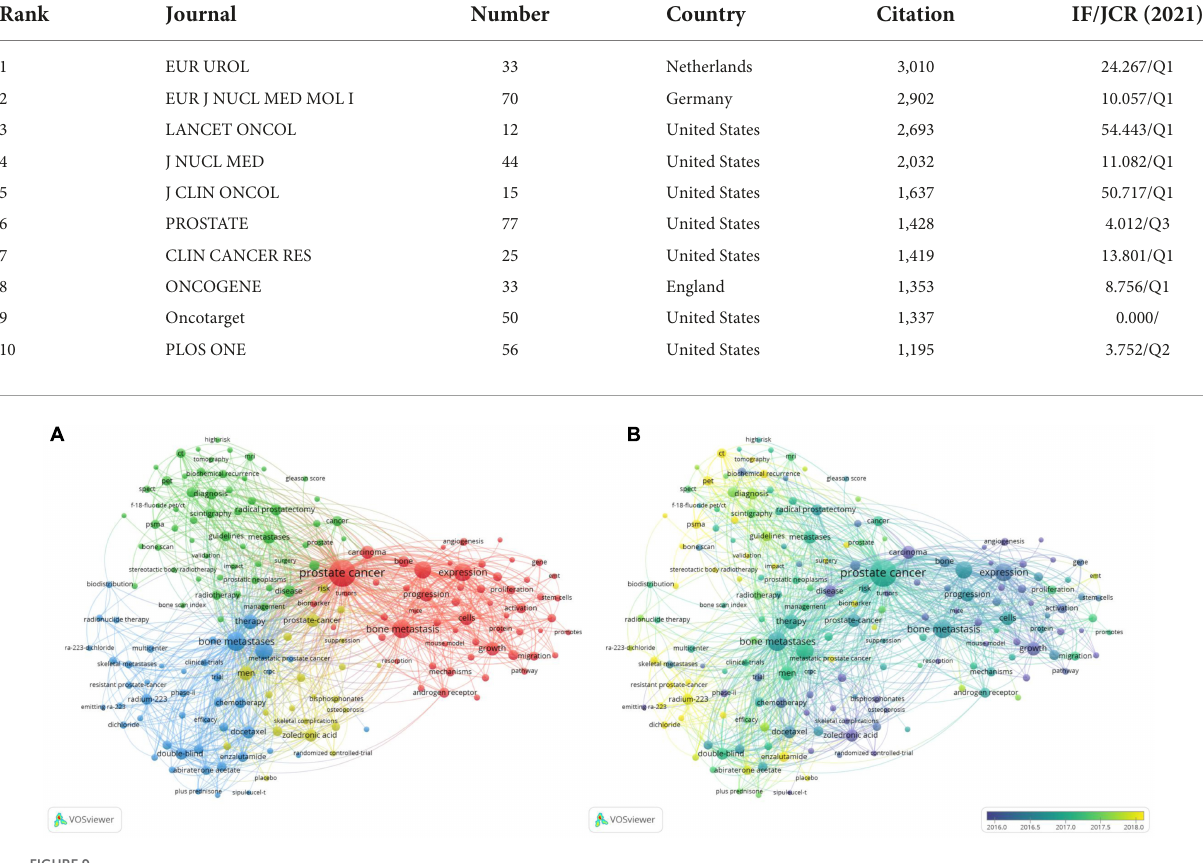
FIGURE9 The bibliometric analysis of the co-occurrence of all keywords in the field of PCa bone metastasis. (A) The network visualization map of high frequency keywords in the field of PCa bone metastasis. (B) The overlay visualization map of high frequency keywords in the field of PCa bone